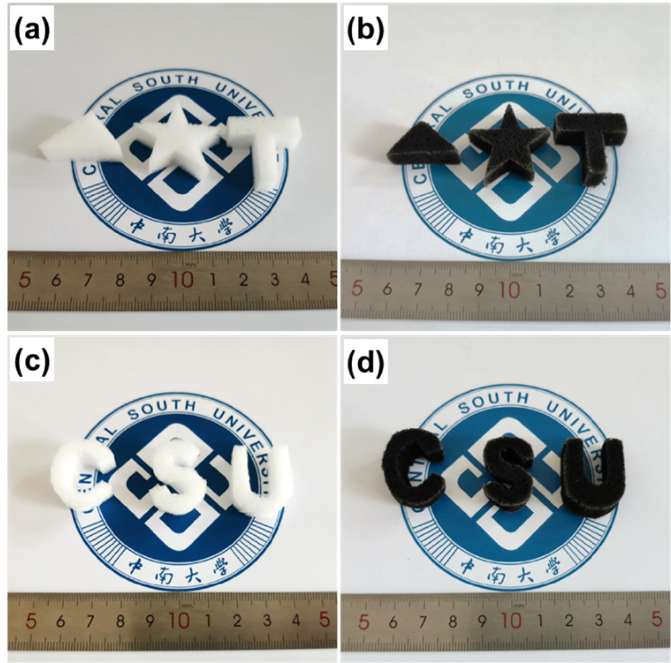
Figure 5. Different sizes and shapes of MF ( a , c ) and MF/Ti 3 C 2 T x /PmPD ( b , d